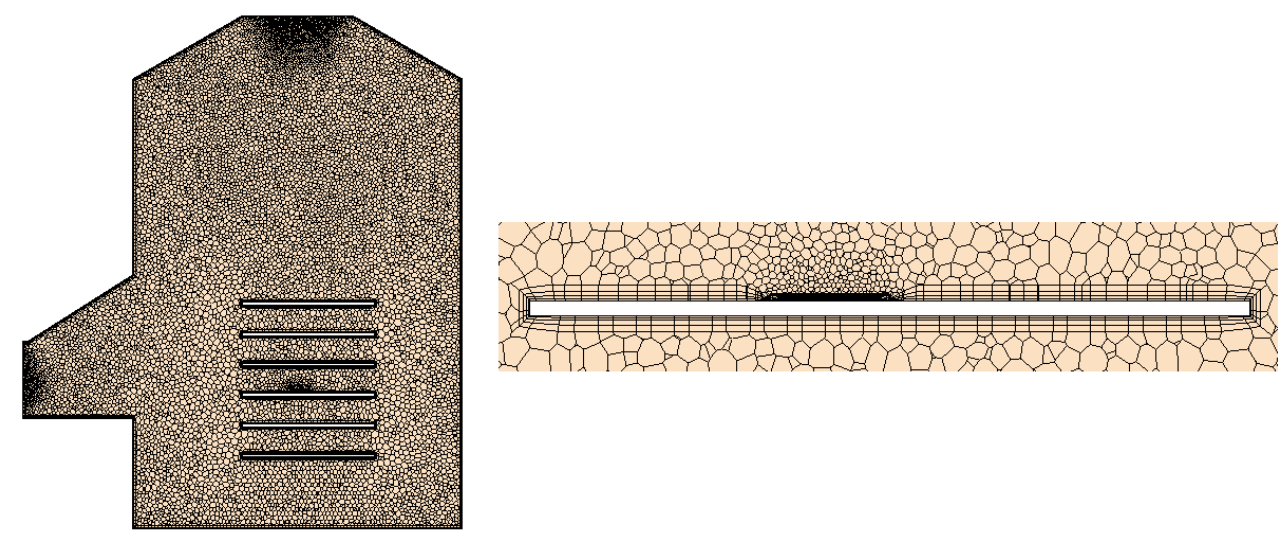
Figure 3. Visualisation of the grid in the studied chamber with a sample.